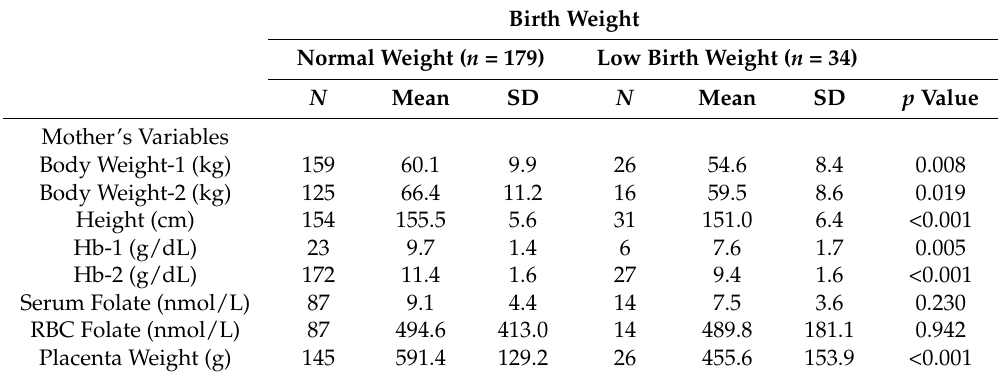
Body Weight-1: First prenatal visit weight, data were extracted from health passport book; Body Weight-2: Measured prior to delivery; Hb-1: Hemoglobin status at first prenatal clinic visit, data was extracted from health passport book; Hb-2: Hemoglobin level measured prior to delivery; IFA, iron and folic acid.